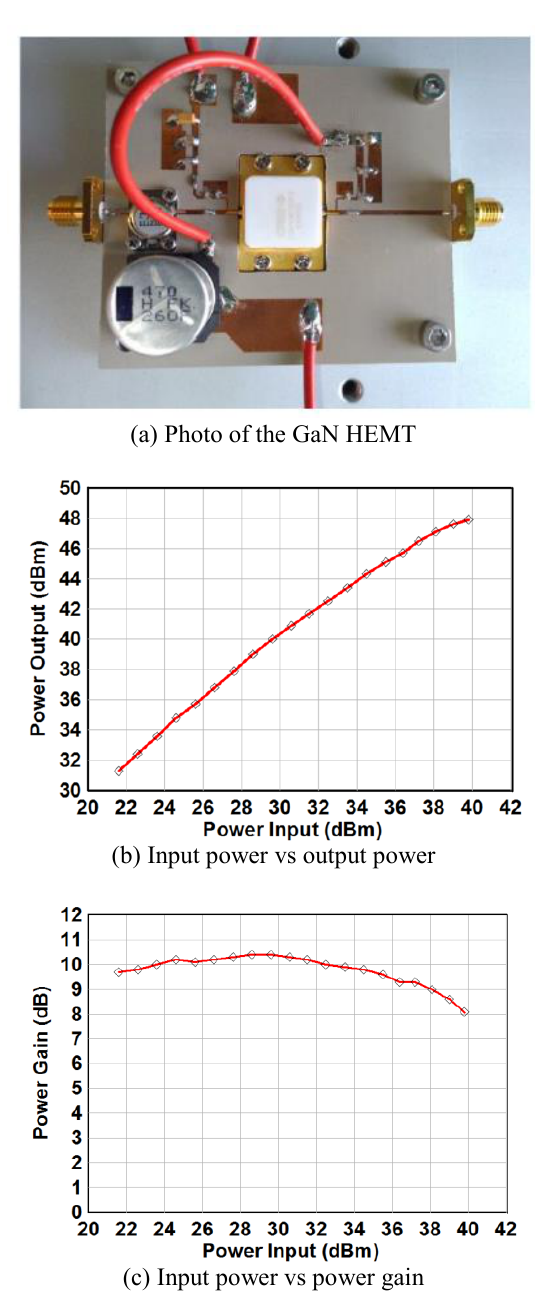
Figure 2: Geometry of the proposed X-band GaN high- power amplifier.